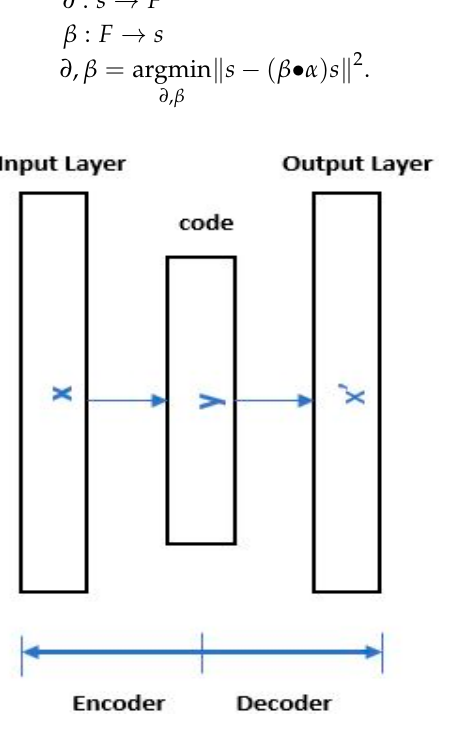
Figure 5. Structure of a basic autoencoder.